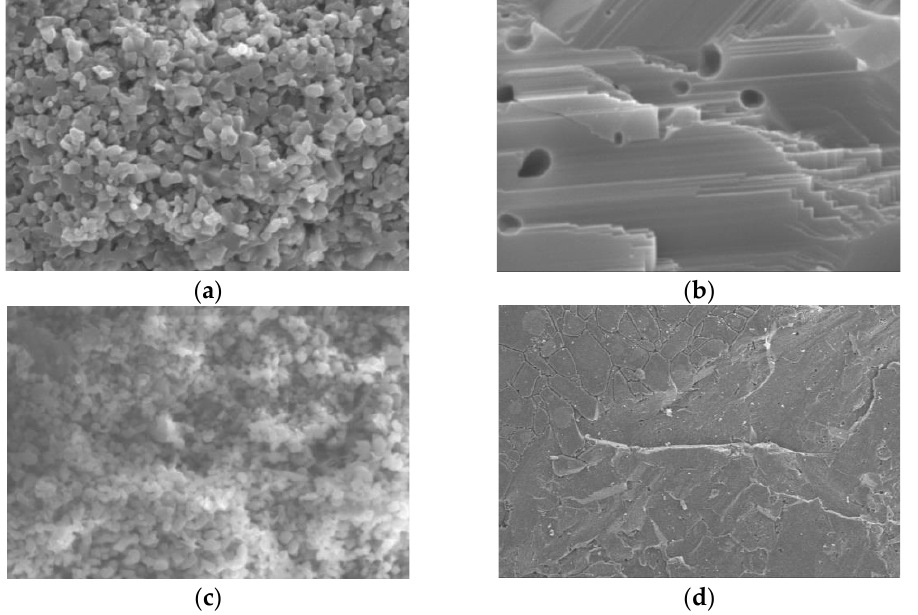
Figure 1. ( a ) A1La5 ceramic processed at 1500 °C, scale 10 μ m; ( b ) A1La10 ceramic processed at 1815 °C, scale 50 μ m evidences intragranular porosity and fracture planes; ( c ) A1La10 ceramic processed in plasma, scale 10 μ m; ( d ) A3La10 ceramic processed at 1815 °C, scale 250 μ m, with both compacted areas and grain